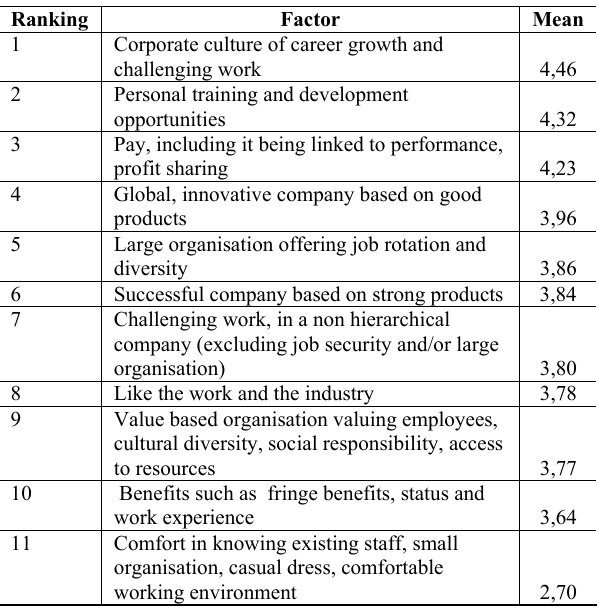
Table 3: Employers of choice factors ranked in order of importance, over all demographic